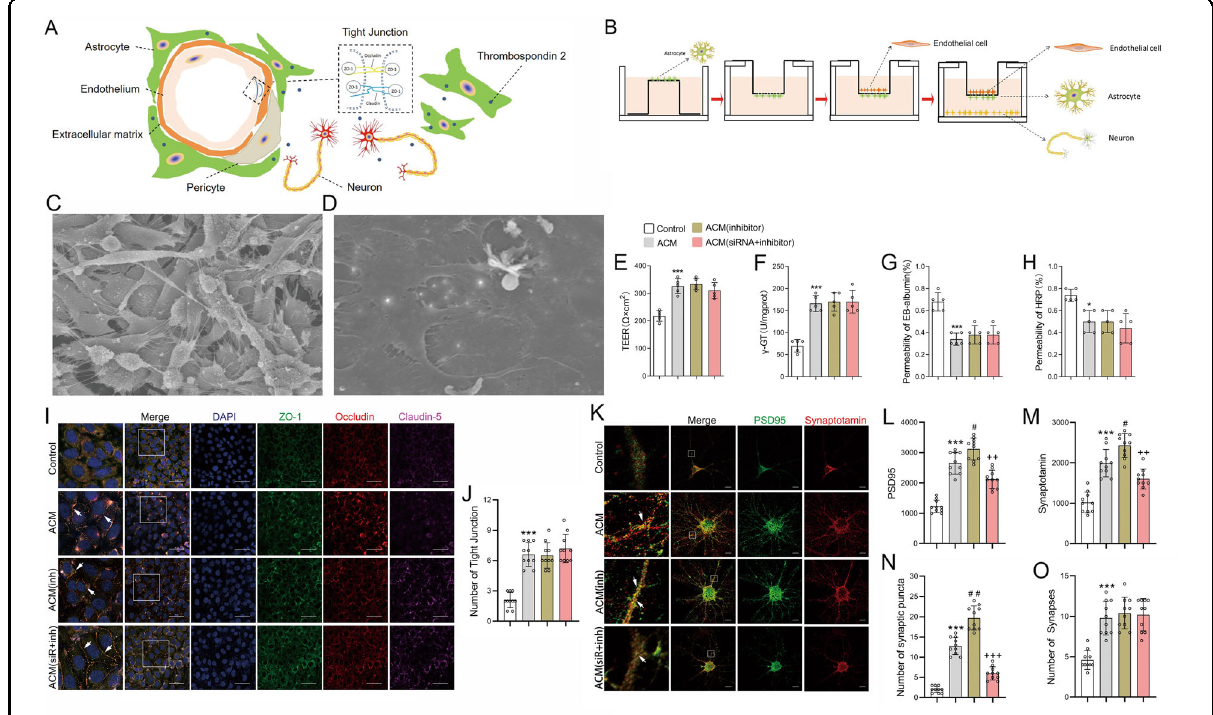
Fig. 4 The effect of miRNA-9-5p inhibitor on BBB stability and synaptogenesis in vitro. A Schematic of the NVU. B The procedure used to reconstruct the NVU in vitro. C BMECs and D astrocytes visualized by scanning electron microscopy (bar = 30 μ m). Quantitative data of the effects of the miRNA-9-5p inhibitor on E TEER, F γ -GT activity, and G EB and H HRP permeability in vitro ( n = 5/group). I The immuno fl uorescence (bar = 50 μ m) and J quantitative data of the tight junction structure in vitro. K The immuno fl uorescence (bar = 10 μ m) and quantitative data of L PSD-95 and M synaptotagmin in neurons. The numbers of N synaptic puncta and O synapses of neurons ( n = 10/group) (* P < 0.05, *** P < 0.001 versus the control group; # P < 0.05, ## P < 0.01 versus the ACM group; ++ P < 0.01, +++ P < 0.001 versus the ACM (inhibitor) group) (ACM: astrocyte co-cultured model, inh: inhibitor, siR: siRNA). Error bars indicate mean ±